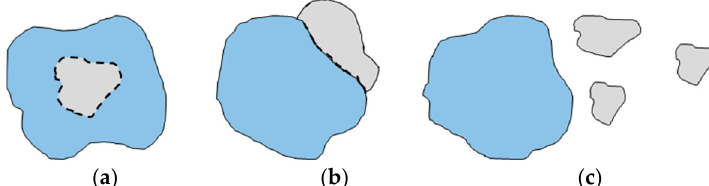
Figure 3. Types of urban growth: ( a ) infilling growth; ( b ) edge expansion; ( c ) outlying growth.